Question: Condense the content of this figure into a single sentence.
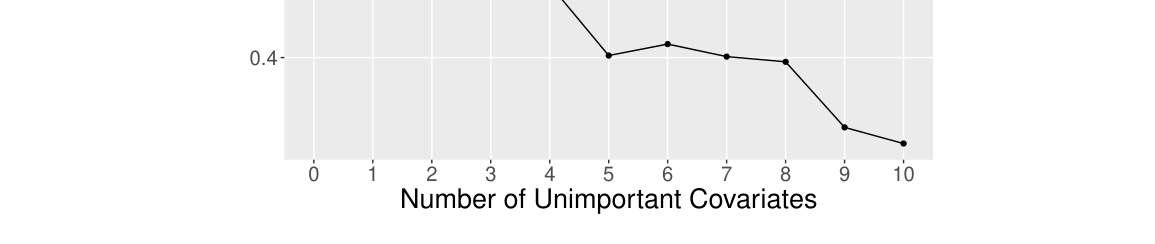
Answer: Number of unimportant covariates versus the probability of selecting the correct hidden-layer structure.